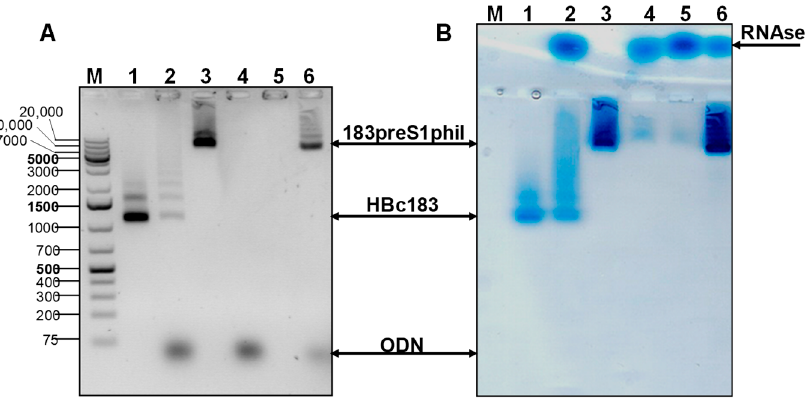
Figure 12. Packaging of ODN 1668 in the VLPs of 183pS1phil protein in the conditions of treatment with RNase and urea. ( A ) EtBr stained NAGE, of HBc and 183preS1phil VLPs before and after treatment: M—marker (GeneRuller 1 kb DNA Ladder (SM1331, Thermo Fisher Scientific™, Wal- tham, MA, USA), 1—full-length HBc VLPs (HBc183) without treatment, 2—HBc183 treated with RNaseA and added ODN 1668, 3—183preS1phil VLPs without treatment, 4—183preS1phil VLPs treated with RNaseA and added ODN 1668, 5—183preS1phil VLPs treated with RNaseA and urea, without ODN 1668, and 6—183preS1phil VLPs treated with RNaseA and urea with added ODN 1668. ( B ) The same NAGE gel, stained with Coomassie Brilliant Blue G250. Note: lanes 4 and 5 show the absence of protein which is explained by the precipitation of empty VLPs after treatment with RNase; the supernatants of centrifuged (10 min at 13,000× g ) samples of treated VLPs were loaded on a gel.